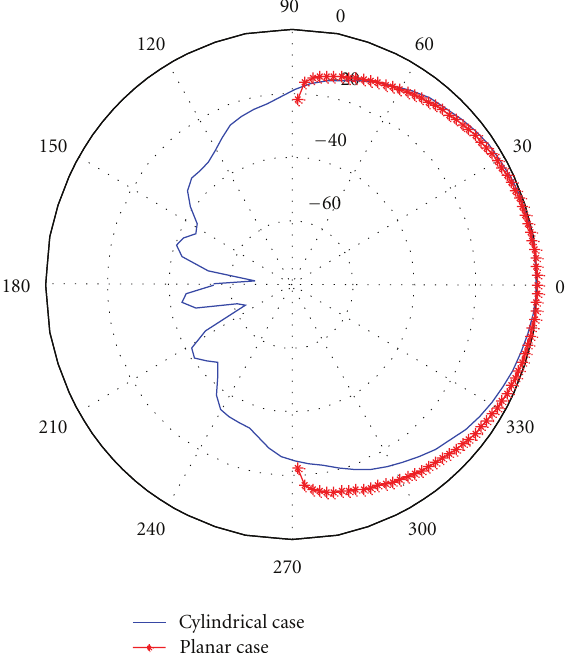
Figure 11: Normalised radiation field in xoy- plane (dB).